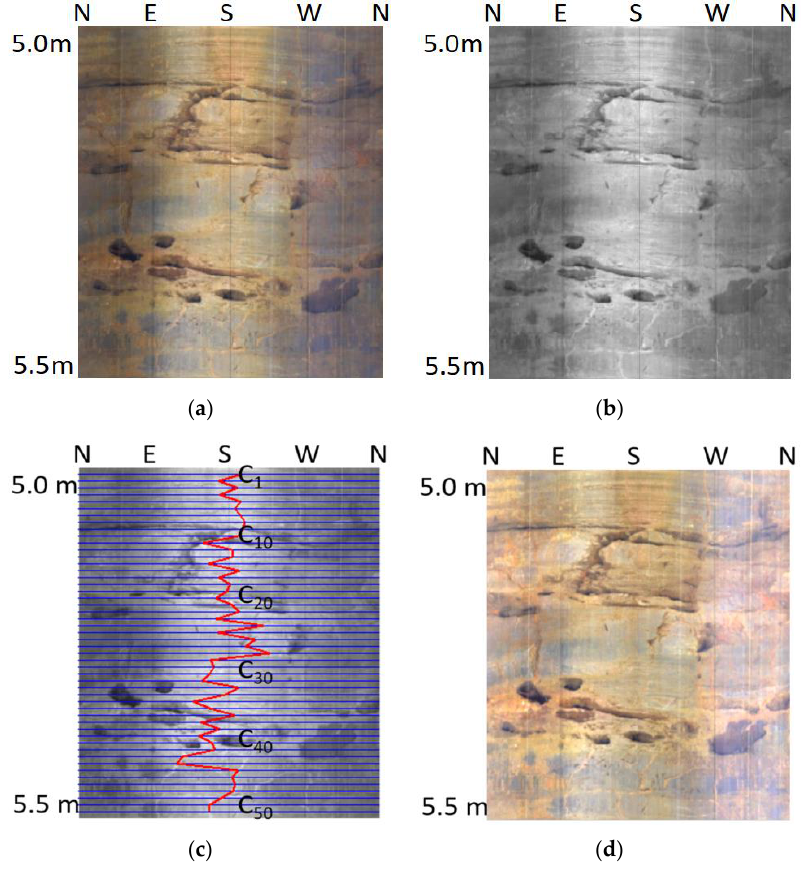
Figure 4. Images before and after borehole image preprocessing: ( a ) original image, ( b ) lightness image, ( c ) bright position change curve, and ( d ) the processed image.